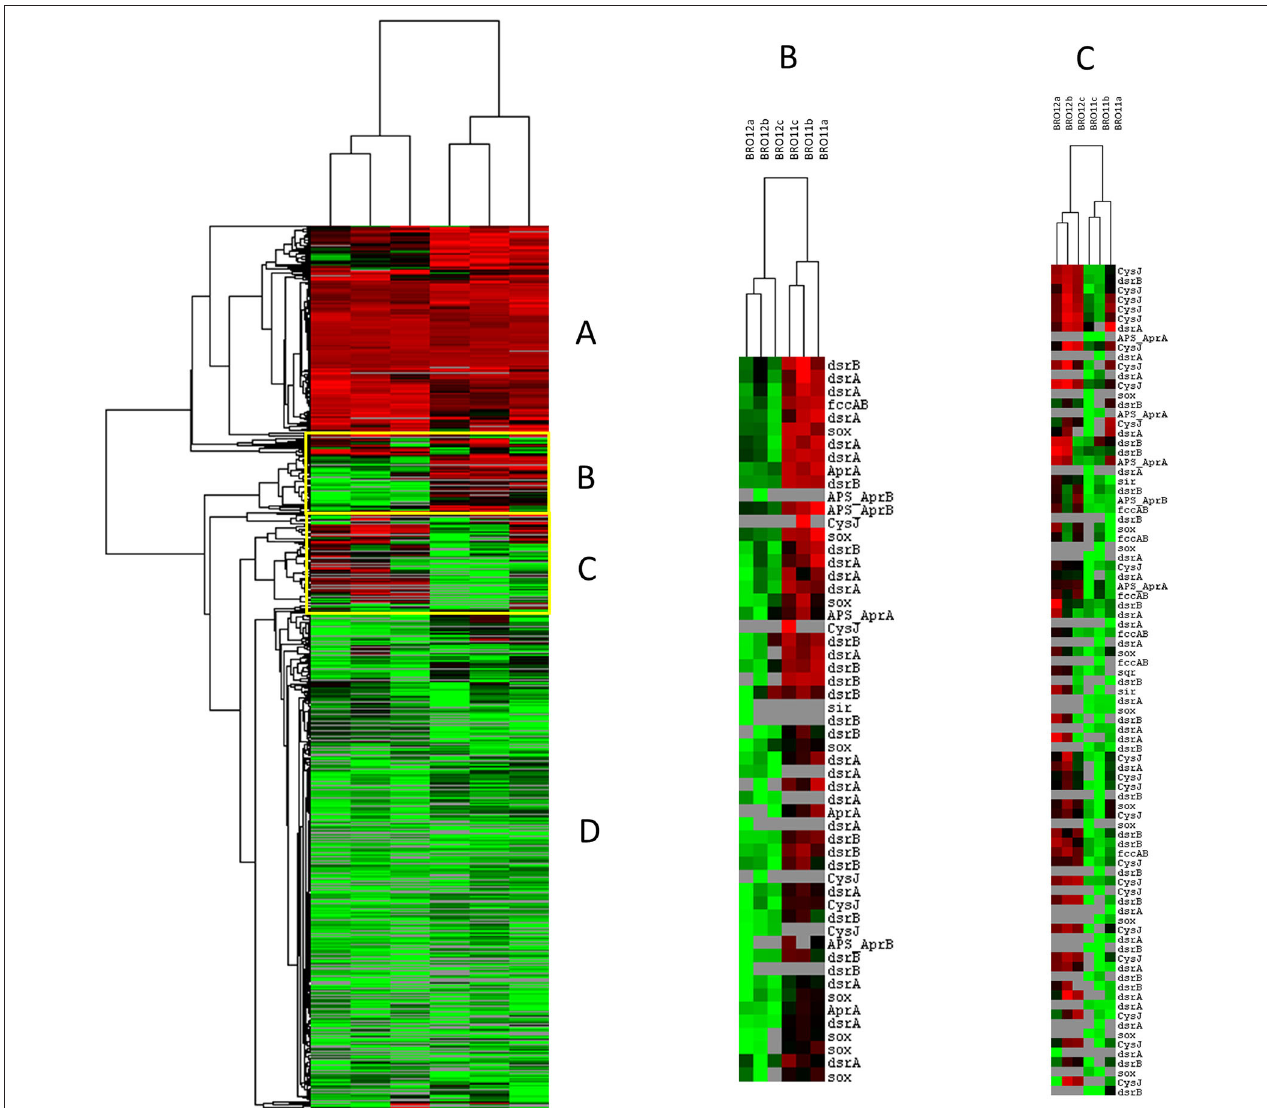
FIGURE 5 | Clustering analysis of sulfur cycling related genes detected using GeoChip 3.0. The figure was generated using CLUSTER and visualized in TREEVIEW. Green and red colors indicate signal intensities respectively below and above the average value of the hybridization signal intensity. The samples from different soils (BRO11 and BRO12) were reported in triplicate. Four different gene patterns were observed and indicated by letters A, B, C,